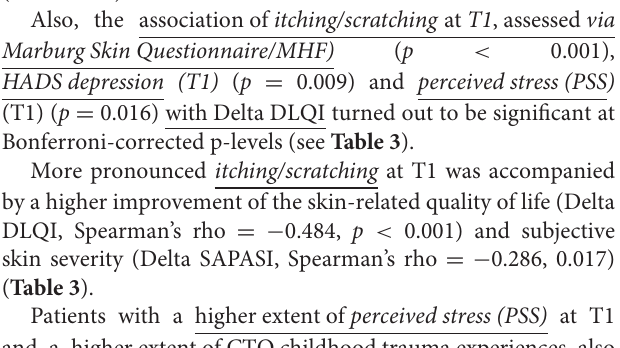
Patients with a higher extent of perceived stress (PSS) at